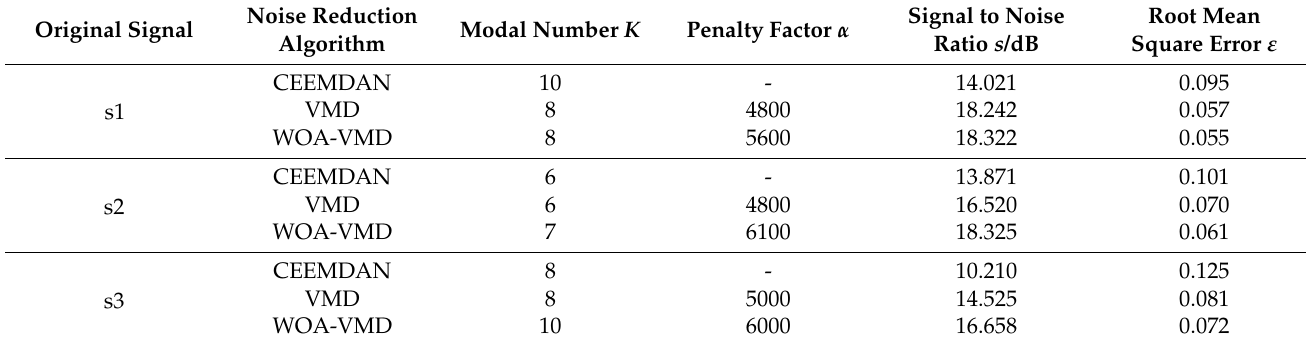
Table 3. Denoised effect